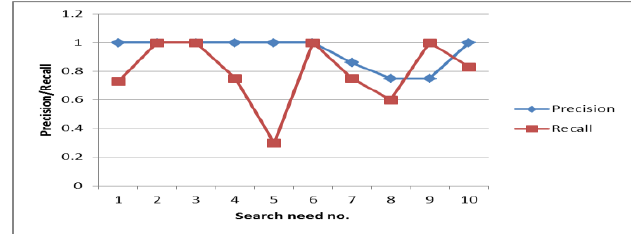
Fig. 15. Linear graph of precision and recall of Law-Torch.